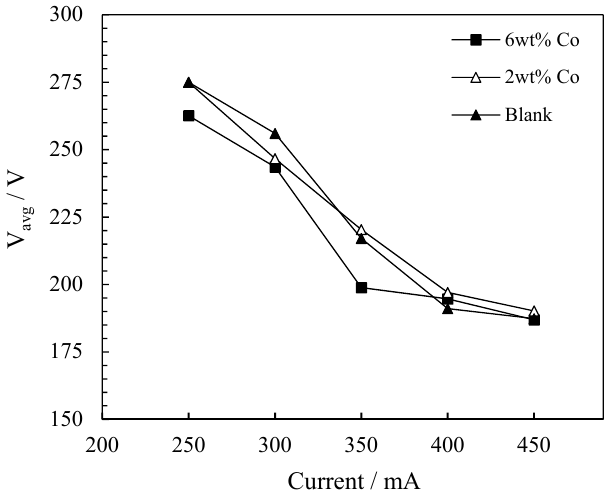
Figure 8. The influence of current on average voltage for plasma-catalytic FTS (NTP + Blank, 2 or 6 wt% Co catalyst) at a discharge time of 60 s. Legend: ■ —6 wt% Co; Δ —2 wt% Co; ▲ —Blank. Operating conditions: Syngas (H 2 /CO) ratio: 2.2:1; pressure: 2 MPa; inter-electrode gap: 1 mm; wall temperature: 25 °C.